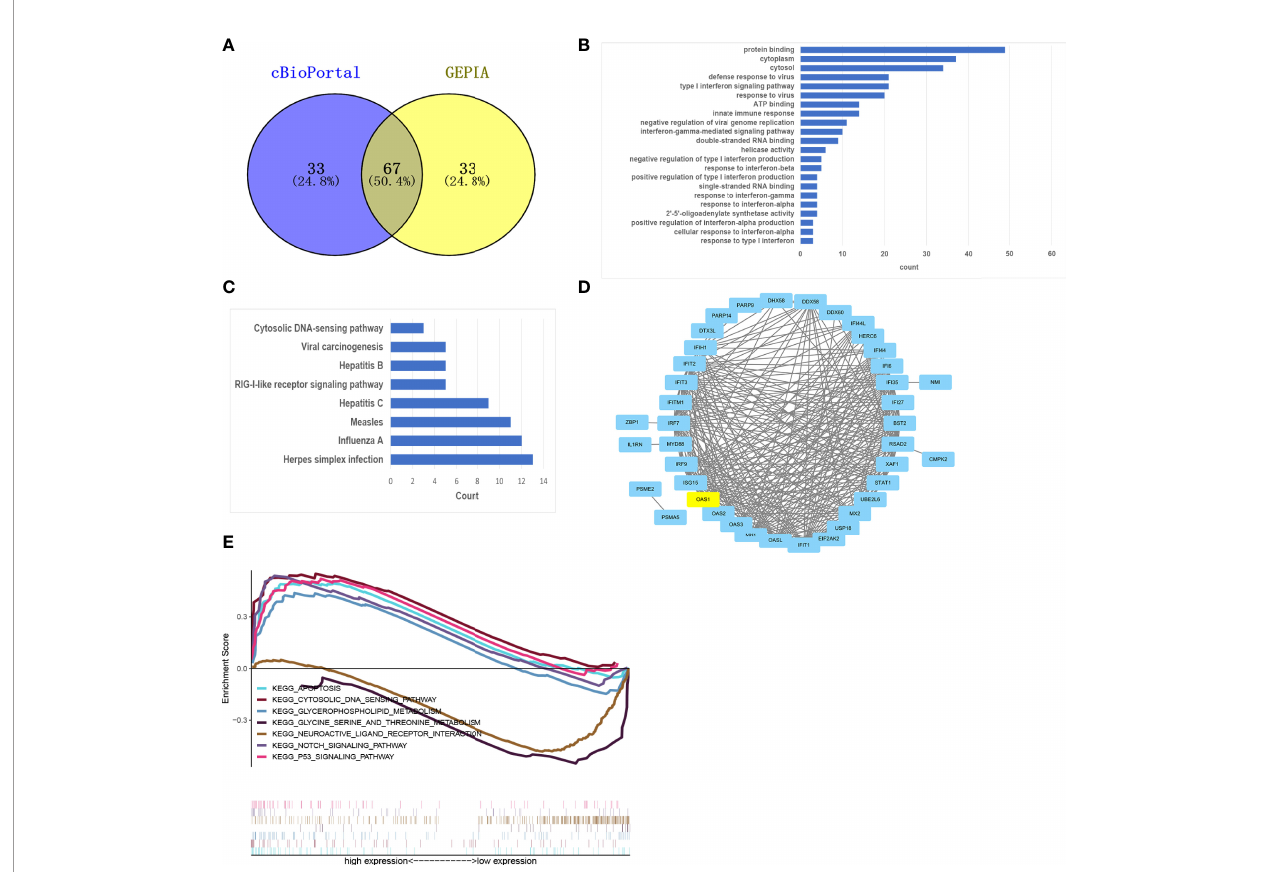
FIGURE 4 | Functional analysis and GSEA. (A) Venn plot showed overlapping genes in GEPIA and cBioPortal databases. (B, C) The 67 OAS1-related genes were analyzed by GO (B) and KEGG (C) enrichment analysis. (D) A PPI network of 67 OAS1-related genes was constructed and visualized. (E) GSEA identi fi es OAS1- related signaling pathways in pancreatic